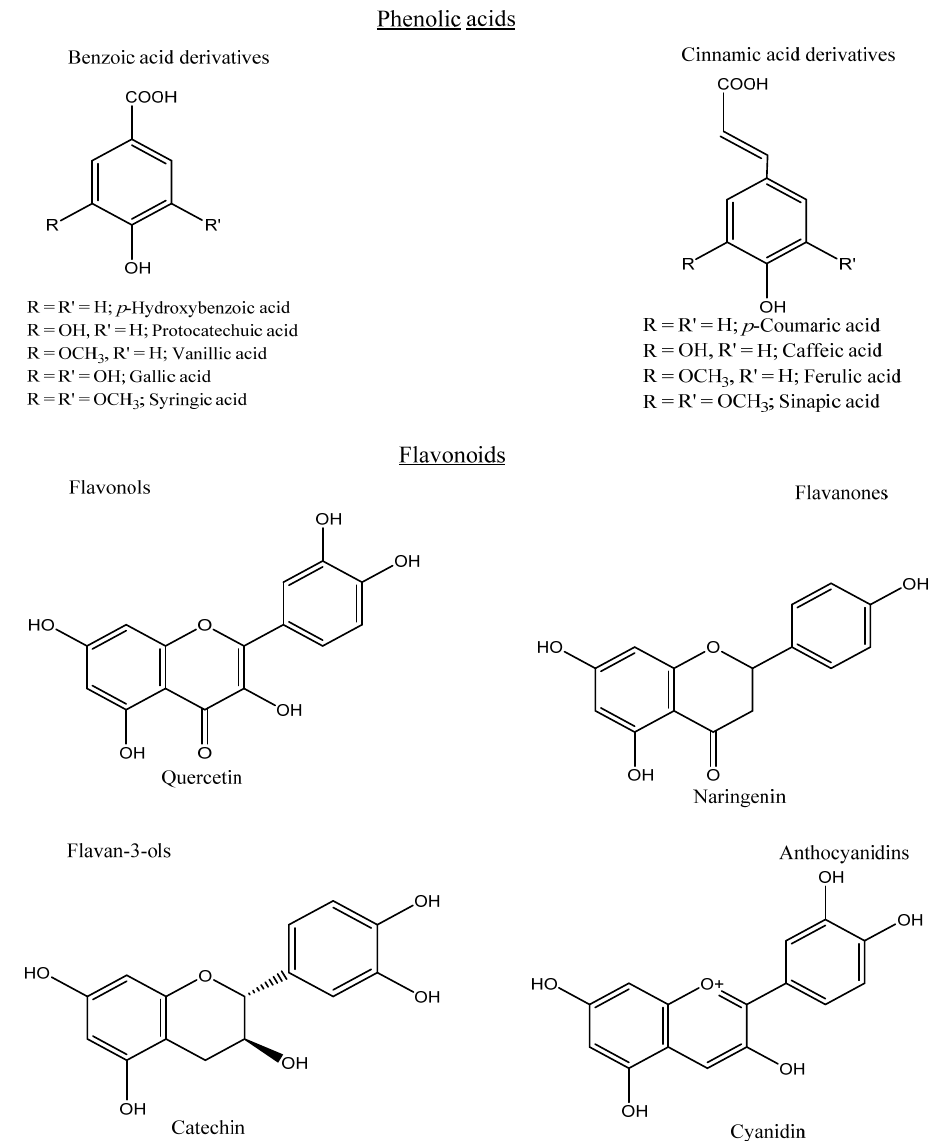
Figure 3. Chemical structures of some phenolic acids and flavonoids.